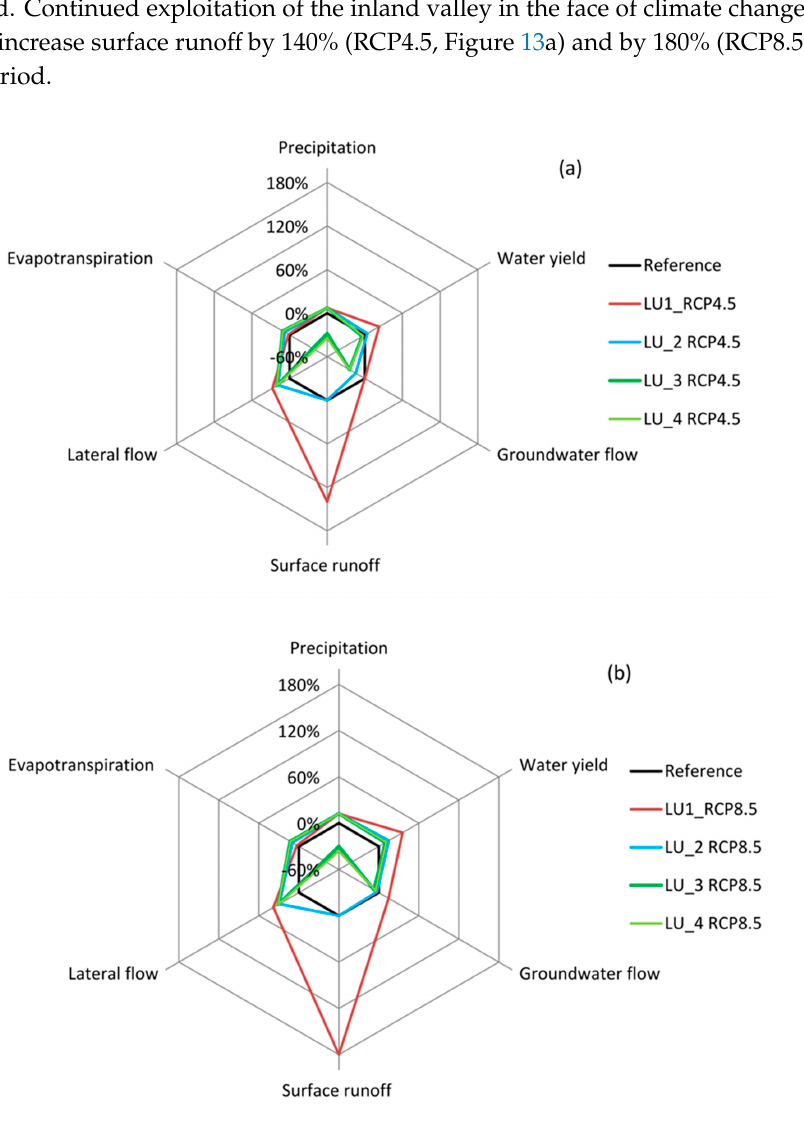
Figure 13. Projected changes in water balance according to the combined LULC and climate scenarios. ( a ), represents changes under RCP4.5 and LULC; ( b ), represents changes under RCP8.5 and LULC; LU1, Exploitation ; LU2, Protection of headwater catchment ; LU3, Conservation approach; and LU4, Slope conservation LULC management. Reference includes the current land use (2015) and the historical RCM data (1976 – 2005).